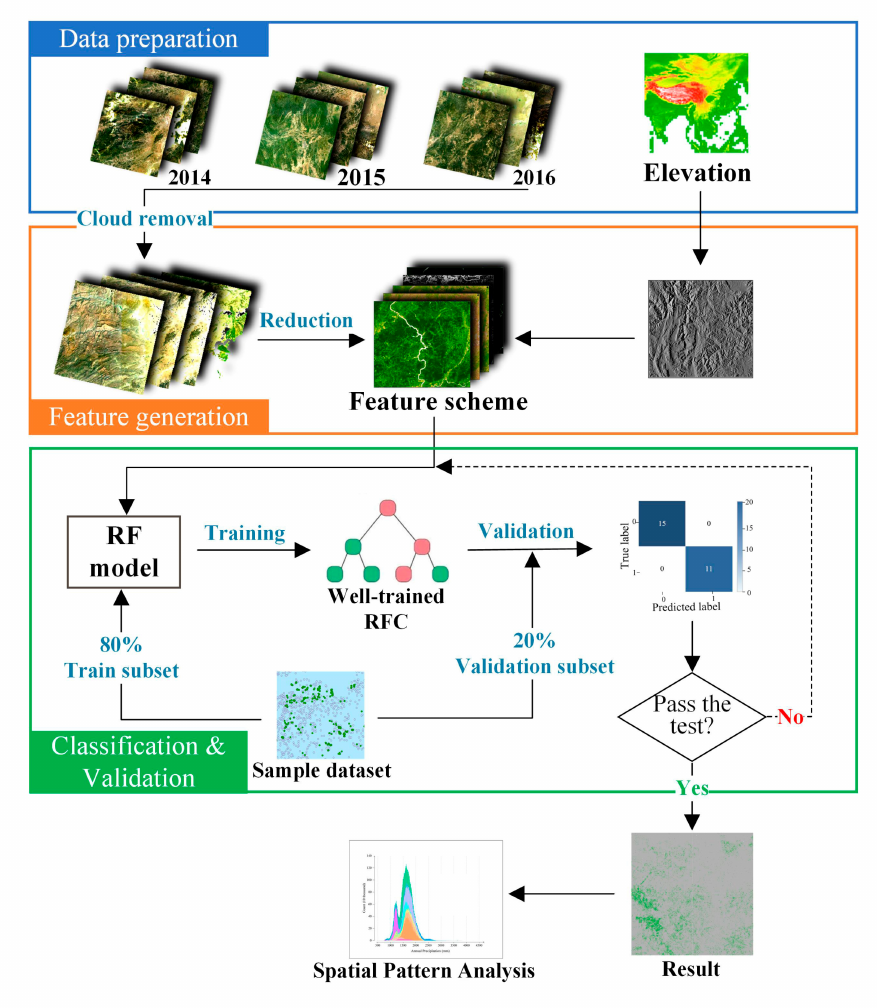
Figure 2. Bamboo mapping methodology and workflow in this study. The SRTM, RF and RFC refer to the Shuttle Radar Topography Mission, random forest and random forest